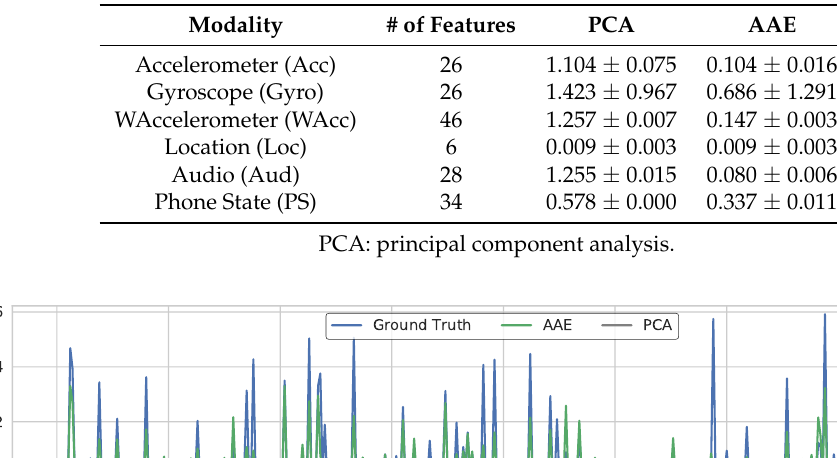
Table 1. Root mean square error (RMSE) for each modality averaged over 5-folds cross-validation.